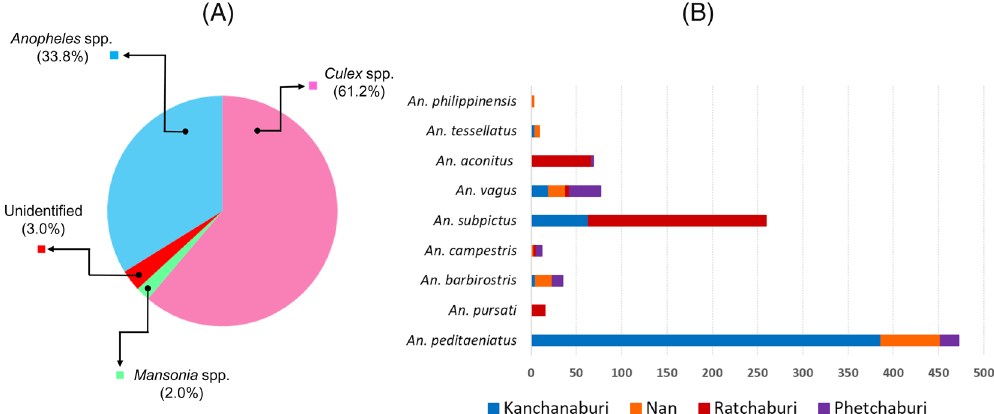
Figure 1. Charts illustrating the composition of mosquitoes determined by morphology. ( A ) The percentages of each genus of mosquitoes collected by CDC light traps in this study. ( B ) The number of mosquitoes of